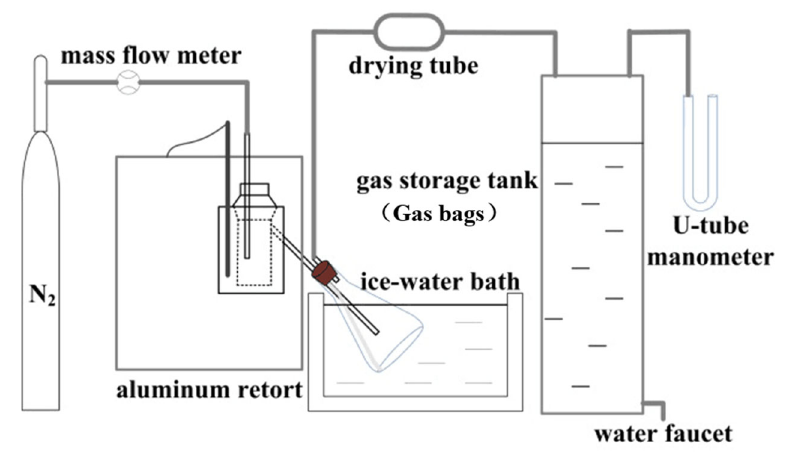
Fig. 1 Schematic diagram of the fixed bed pyrolysis reactor